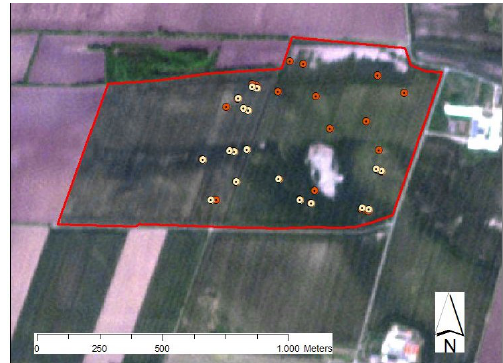
Figure 1. Test site with the sampling locations measured on 8 th of May (dark) and 22 nd of June 2011 (bright). The image shows the situation on the 7 th of May